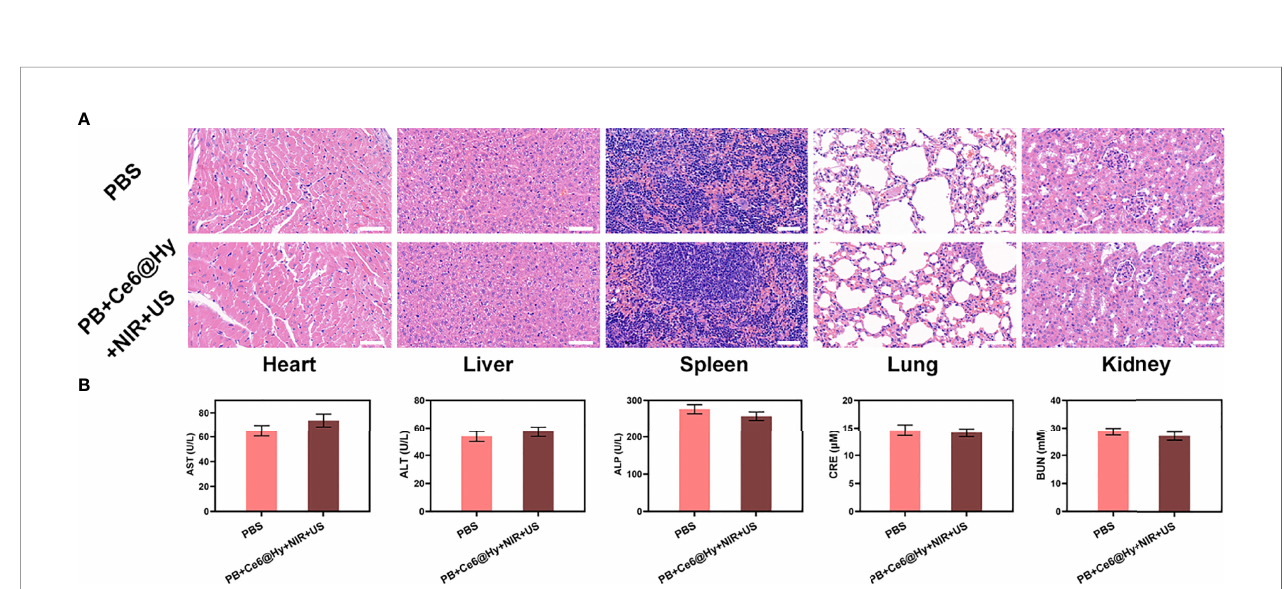
FIGURE 4 | Result of in vivo safety experiments. (A) Histopathological analysis results (H&E stained images) of the major organs, heart, lung, liver, kidneys, and spleen, of mice that were exposed to different treatments 16 days post-injection. Scale bars: 100 m m. (B) Liver, kidney and blood function markers: AST, ALT, ALP, CRE and BUN after various